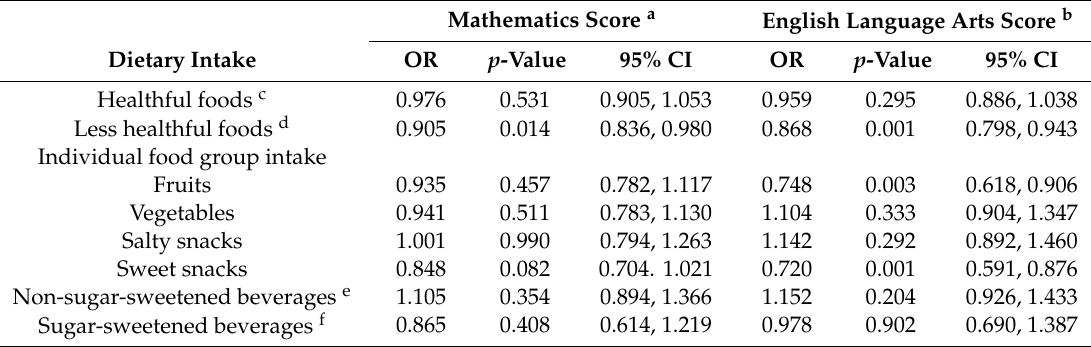
Table 5. Ordered logistic regression models predicting Massachusetts Comprehensive Assessment System mathematics and English language arts score by individual food group intake in the FLEX study population ( n =